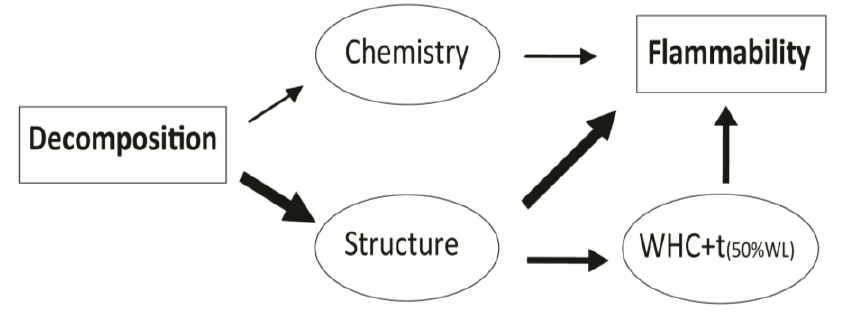
Figure 1. Interactions between twig decomposition and flammability; Decomposition may directly affect twig flammability by altering chemical and structural properties, as well as indirectly via changing twig water dynamics: water holding capacity (WHC) and time until 50% water loss ( t ) of saturated twigs; In hypothesized magnitude from low to high (as (50%WL) indicated by width of arrows), change in chemistry, indirect effects of structure via water dynamics, and direct effects of structure will affect